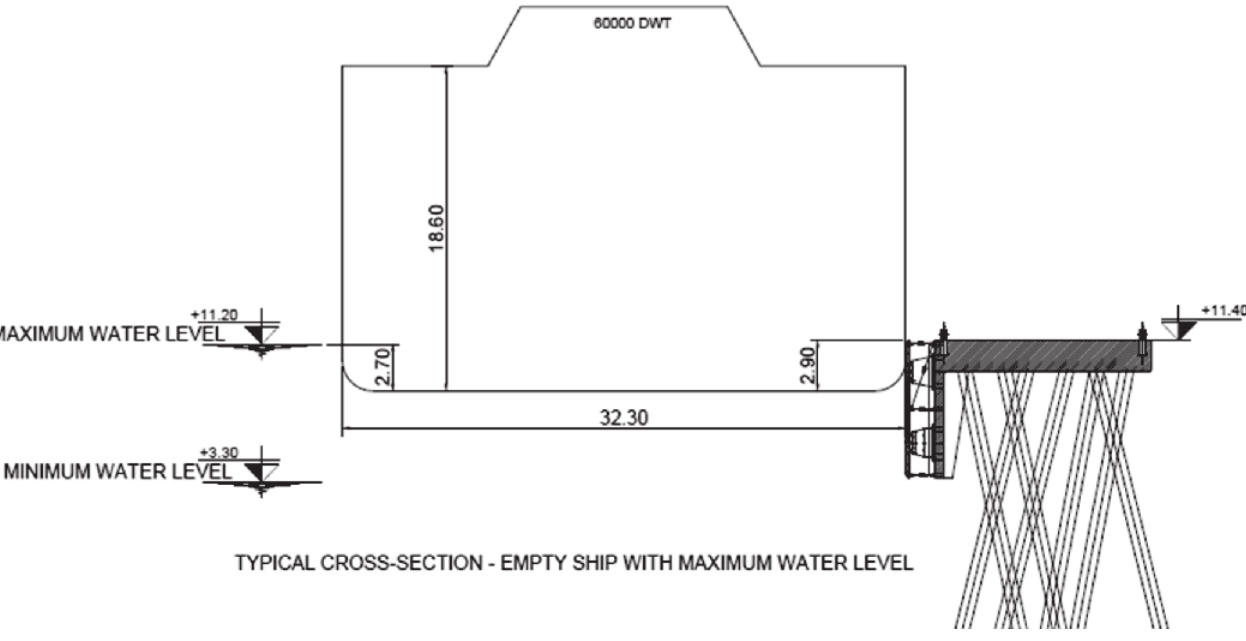
Cross section of an empty ship with a maximum water level